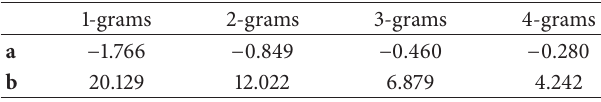
Table 1: Trendline ( 𝑦 = a 𝑥 + b ) coefficients in TanCorp